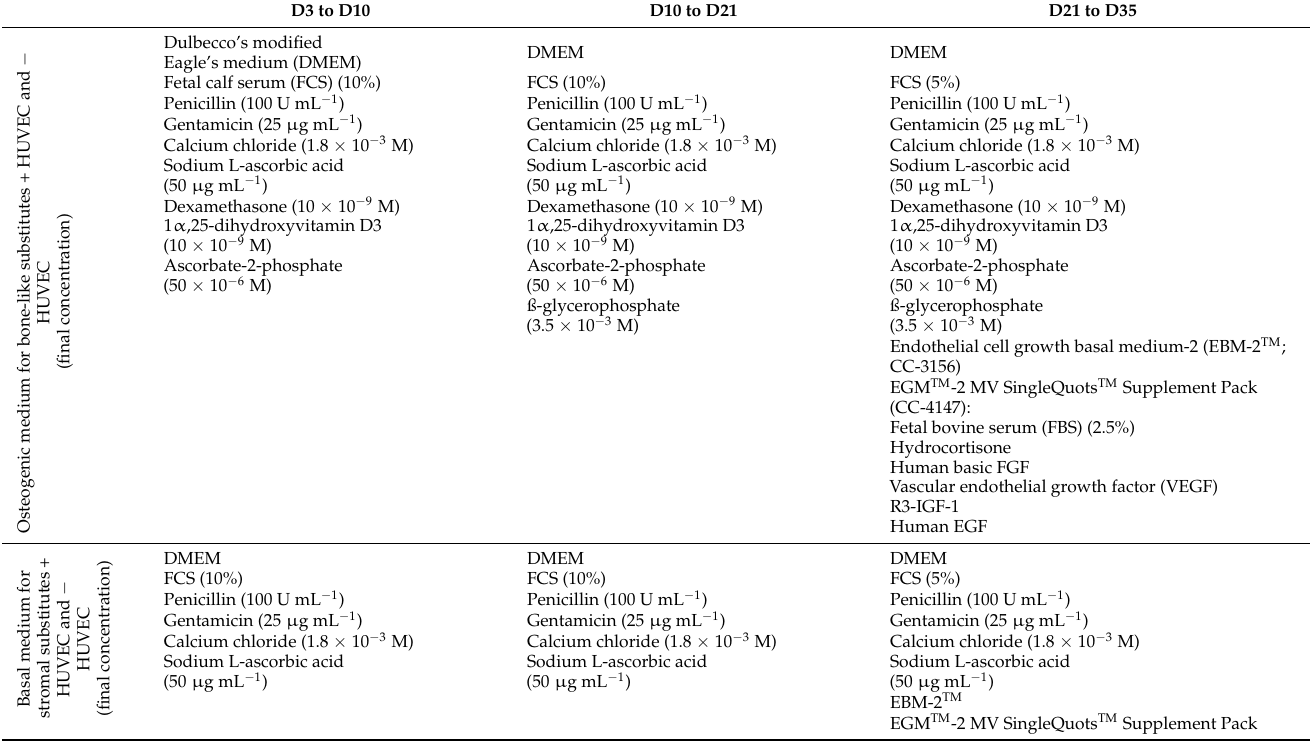
Table 1. Media composition over time in culture for the in vitro production of the